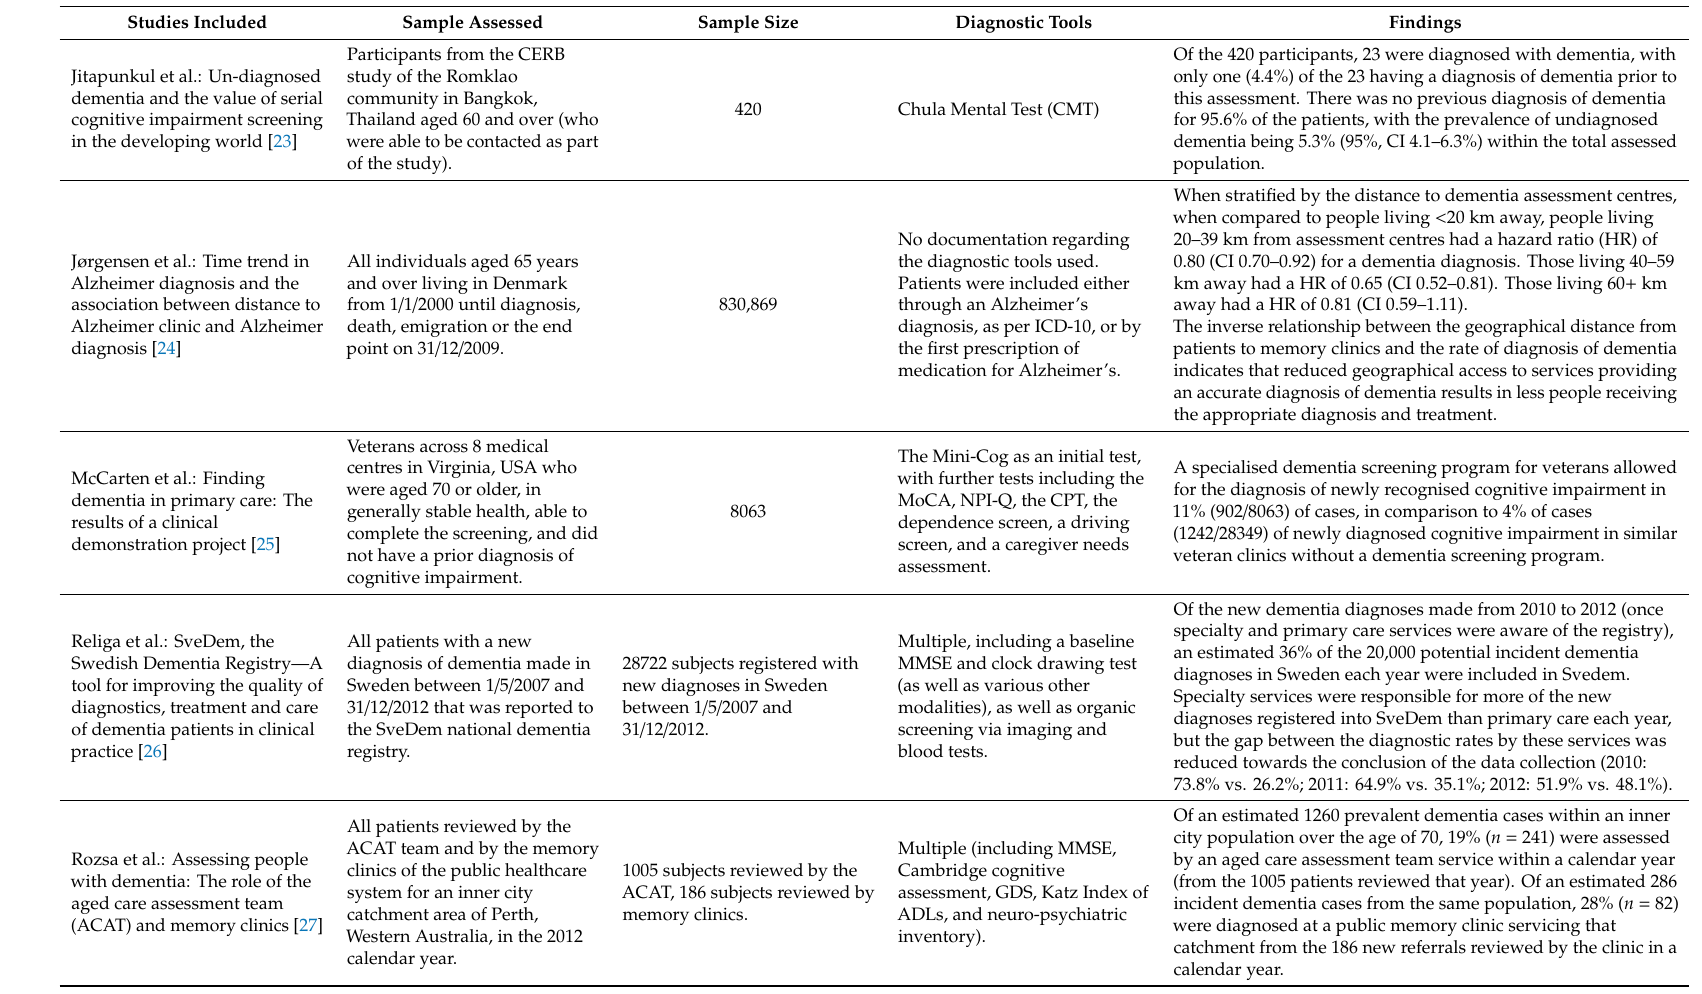
Table 1. Description of the included